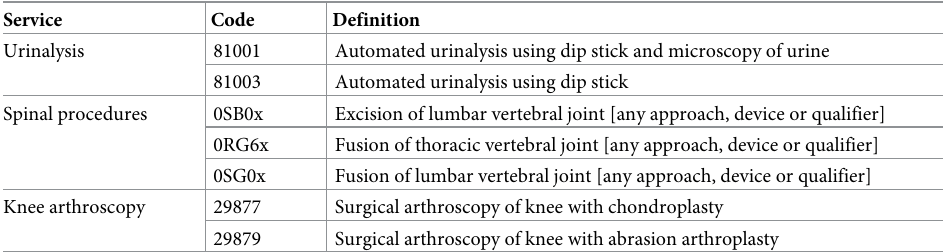
Table 1. The selected example codes and their